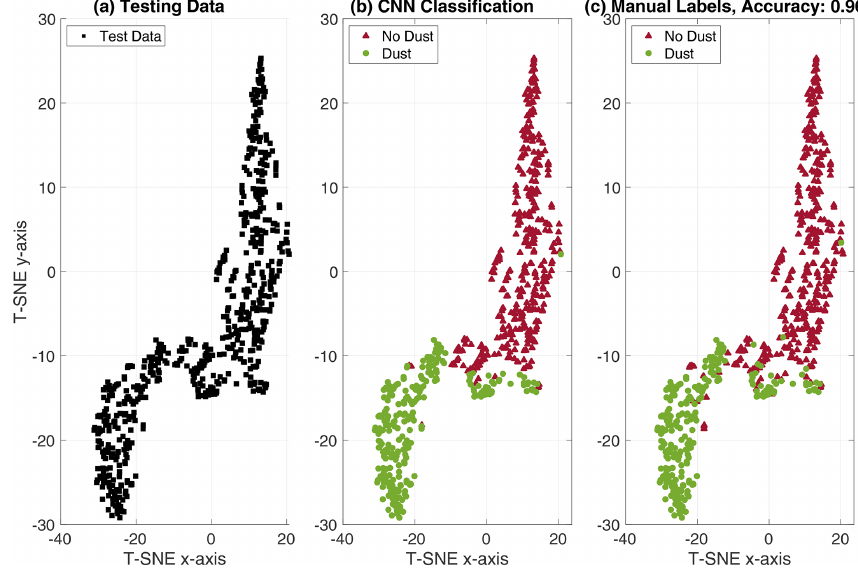
Figure 8. (a) The testing data (600 observations with hidden labels) are visualized by a dimension-reduced t -SNE map, where similar feature vectors are modeled by nearby points, while dissimilar observations are modeled by distant points with high probability. (b) The testing data classified by the trained CNN. (c) The “true” manual labels are presented. Only a few observations, predominantly in the transition region between the dust and no dust observations, are confused. An overall classification accuracy of 96% is calculated by comparing the labels predicted by the CNN to the manual labels. Note that the presented testing data is the same data set that was used to test the SVM classifier, illustrated in Fig.